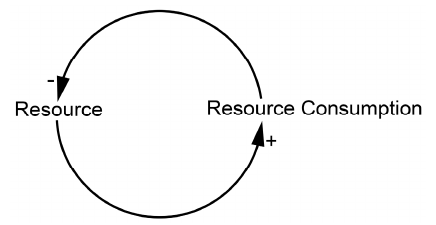
Figure 1. Balancing, negative feedback loop.